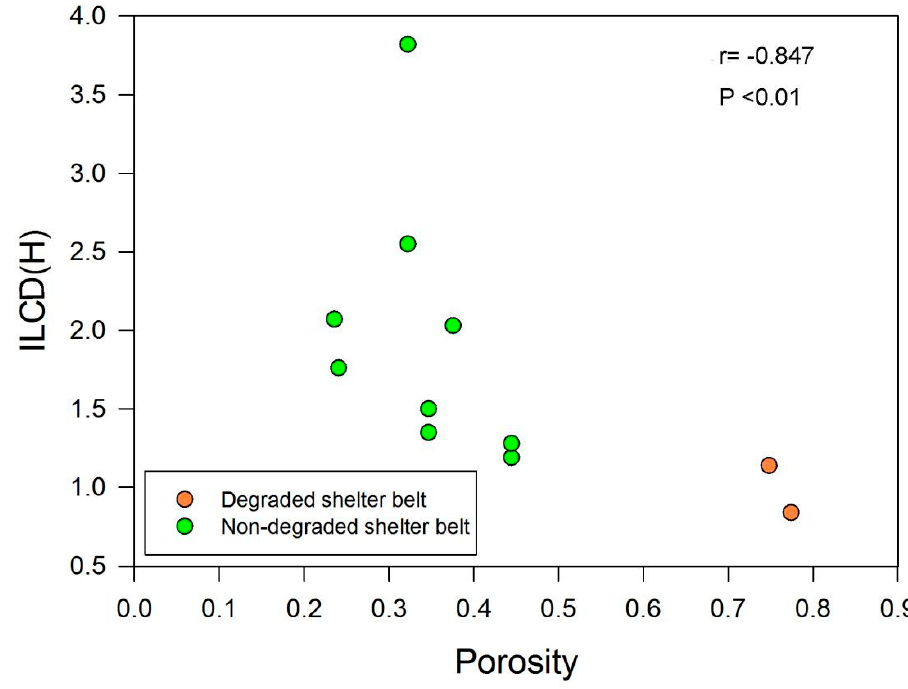
Figure 5. Scatterplot of the shelter forest porosity and ILCD (r = − 0.847, p < 0.01).